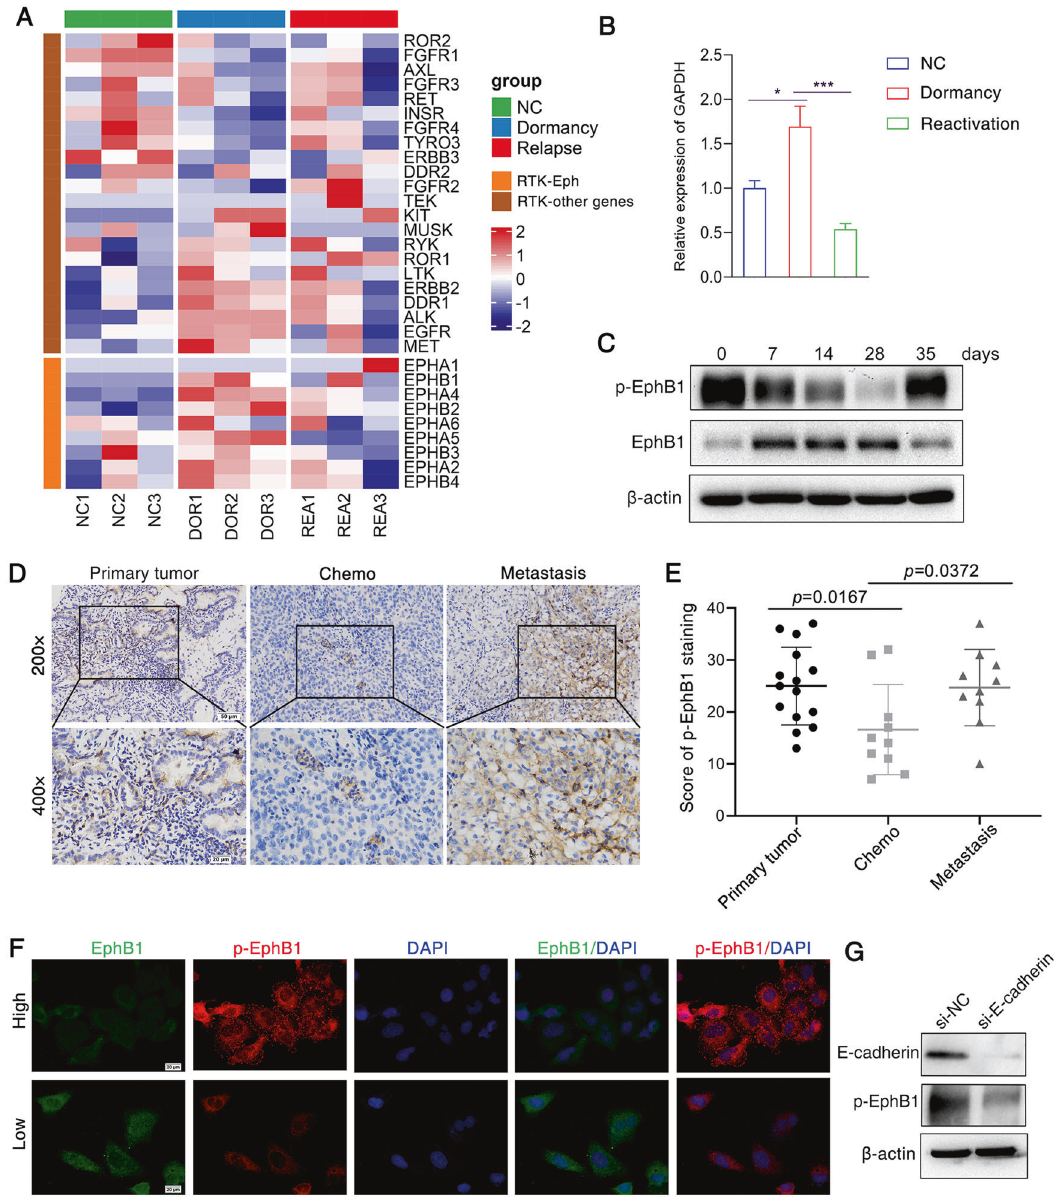
Fig. 5 EphB1 and p-EphB1 show dynamic expression in dormant and relapse cancer cells. A The heatmap of the expression of receptor tyrosine kinases (RTKs) genes between 3 cell phases induced by cisplatin; The fi nal heatmap was plotted after being balanced by the Z -score. Z sores were calculated for each row (each gene) by subtracting the mean and dividing by the standard deviation. B RT-qPCR Validation of EphB1 expression. C Western blot analysis of EphB1 and p-EphB1 in cisplatin-treated A549 cells at different time points; D , E Assessment of p-EphB1 in lung cancer patients. Tumor biopsies were fi xed and stained for p-EphB1. Scale bar = 20 μ m; The immunohistochemical scores were shown on the right; Student ’ s t test, P values were shown. Primary tumor: biopsies from lung primary tumors; Chemo: biopsies from lung tumors after neoadjuvant chemotherapy; Metastasis: biopsies from metastatic brain of lung cancer patients; F Immuno fl uorescence images of lung cancer cells with different cell density. Cells were planted in 6-well plates at different cell density. Cells at different density were incubated with RFP-conjugated p-EphB1 antibody and GFP-conjugated EphB1 antibody. Cells were counterstained with DAPI. Scale bar = 20 μ m; G Western blot analysis of proteins obtained from si-E-cadherin-treated A549 a tumor suppressor gene, continuous expression of E-cadherin in metastasis has been reported [35]. Many metastases express E-cadherin and functional state of E-cadherin in response to environmental factors is an important determinant of metastatic potential instead of the expressional states [36]. E-cadherin- mediated cell-cell contact promotes the formation of circulating tumor cell (CTC) cluster. CTC cluster show selective advantages versus single CTCs [37]. In this study, the surviving lung cancer cells